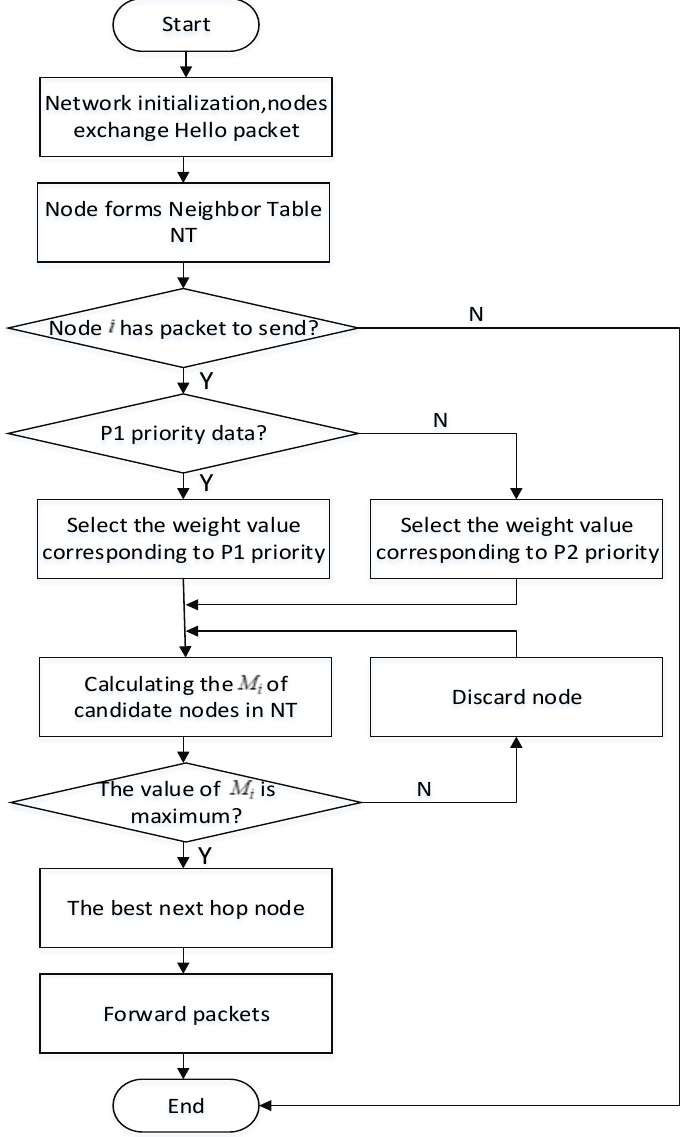
Figure 3. Flow chart of the proposed protocol .